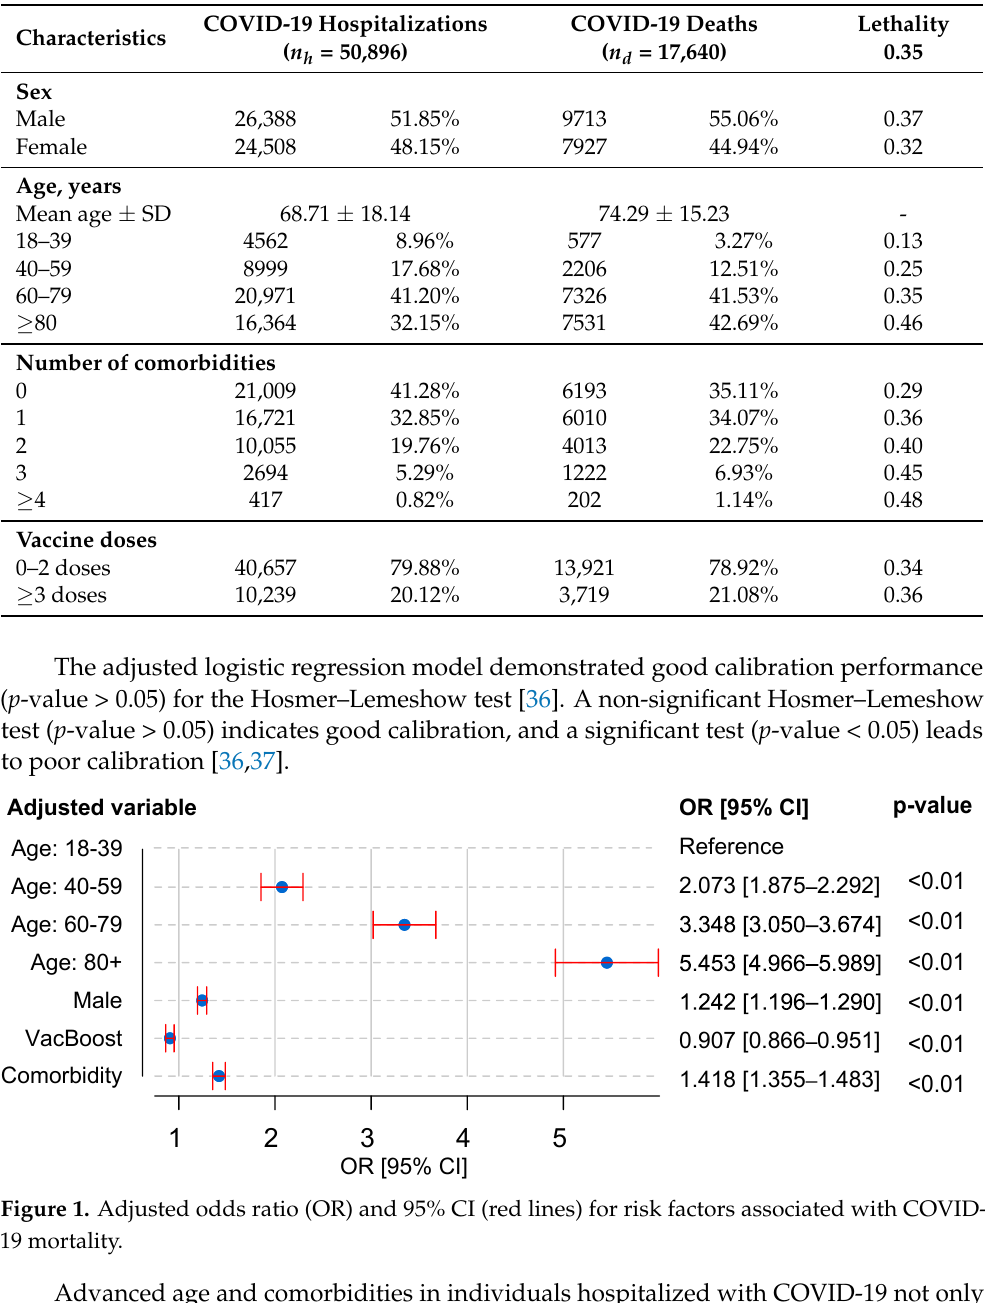
Table 1. Personal and medical statistics for confirmed SARS-CoV-2 hospital admissions between 1 February and 31 March 2022, in Brazil.